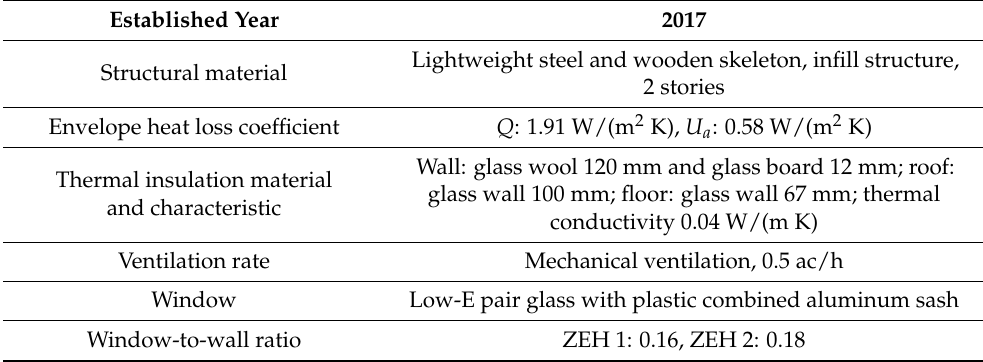
Figure 1. Typical scenario of the ZEH construction process with a high thermal insulation level envelope. Table 1. Main characteristics of the selected ZEHs.